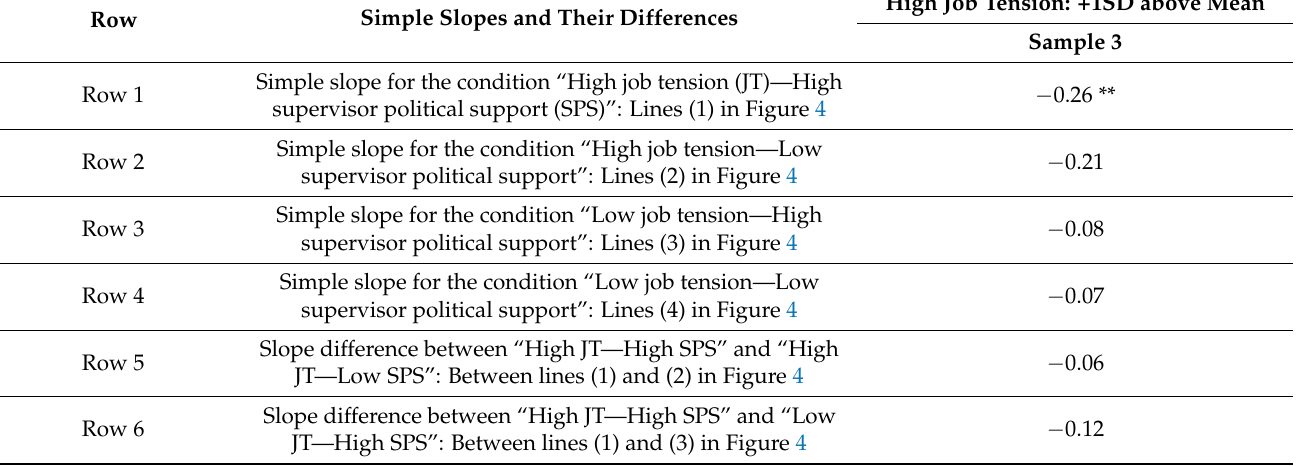
Figure 4. Sample 3: Three-way interaction of side effects of work on health, job tension, and supervisor political support predicting employee well-being. Note: Calculations are based on coefficients from Table 5 . Table 7. Slope difference tests of three-way interaction of side effects of work on health, job tension, and SPS predicting employee well-being. Note: From Figure 4 .